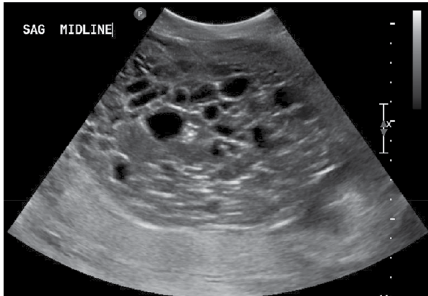
Figure 2: Ultrasound appearance of the molar component of the pregnancy.